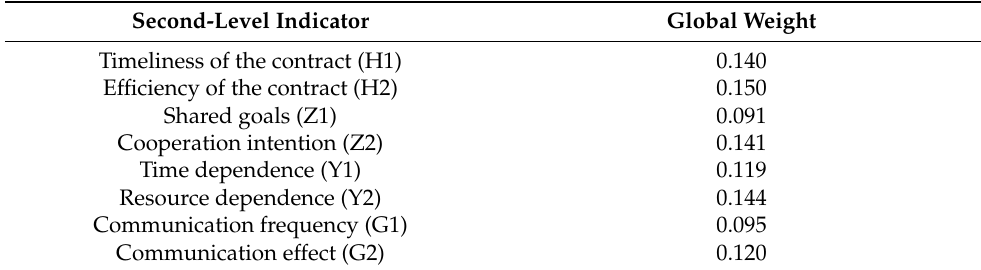
Table 3. Index weights of governance